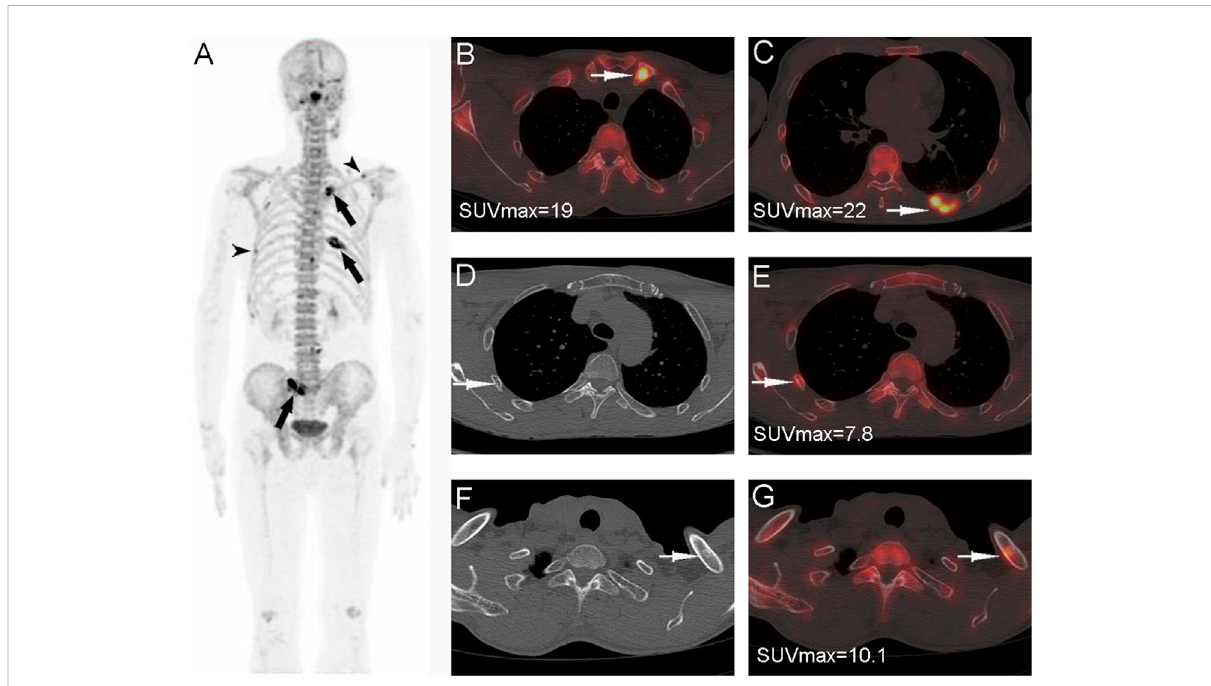
FIGURE 5 Nasopharyngeal carcinoma (T3N2M1) in a 55-year-old male patient. Whole-body PET MIP (A) shows multiple abnormally 18 F-NaF uptake in multiple ribs, the right sacroiliac joint, and the left clavicle; the SUVmax of the con fi rmed bone metastases in the left clavicle (B) , PET/CT fusion, arrows and the left 8th posterior rib (C) , PET/CT fusion, arrows is signi fi cantly higher than that in the right rib (D,E) , arrows and the left clavicle (F,G) , arrows for benign lesions (non-fracture, non-osteophytes).